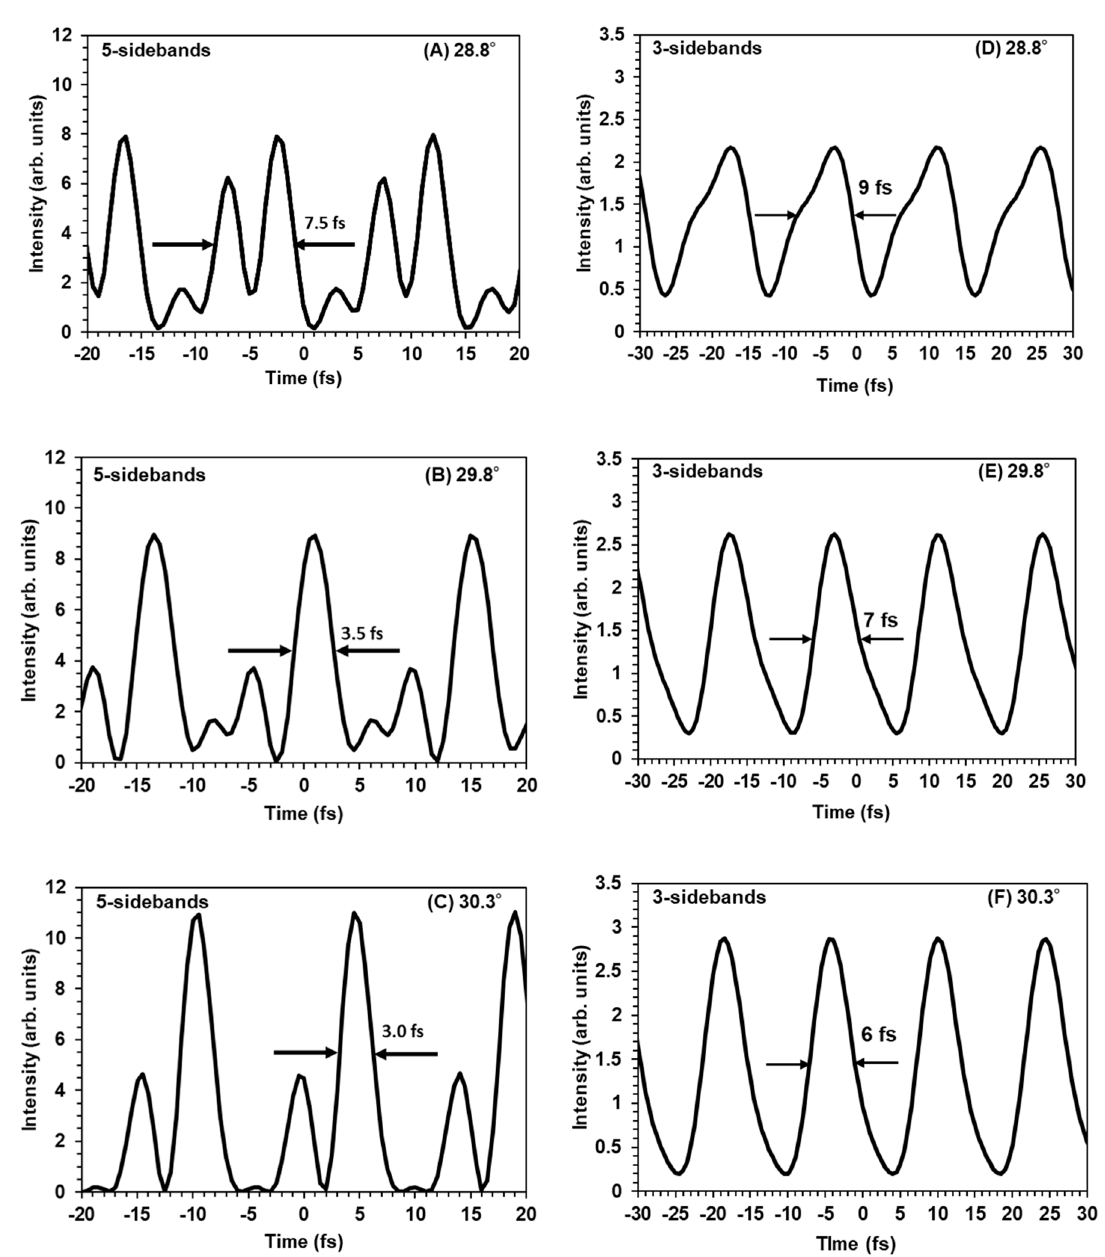
Figure 4. Calculated temporal waveforms at points ( A – F ) corresponding to the three values of the tilt angle shown in Figure 3. Left column plots are obtained assuming contribution of 5 sidebands into the AS3 signal, right—3 sidebands.